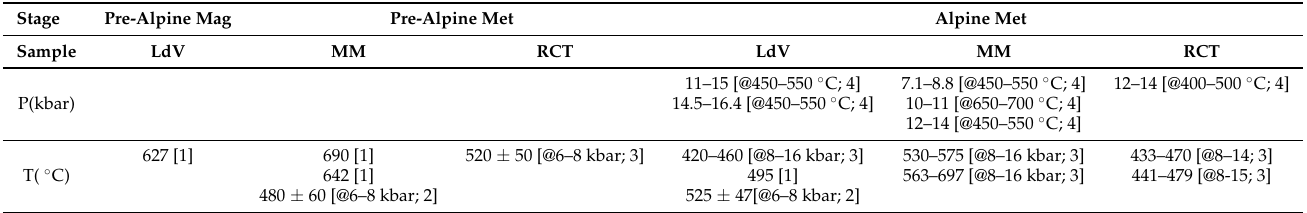
Table 5. Thermobarometric estimates obtained using independent thermometers and barometers and referred to successive stages. (1) Ti in Biotite; (2) Grt-Bt; (3) Grt-Wm; (4) Wm phengitic content.